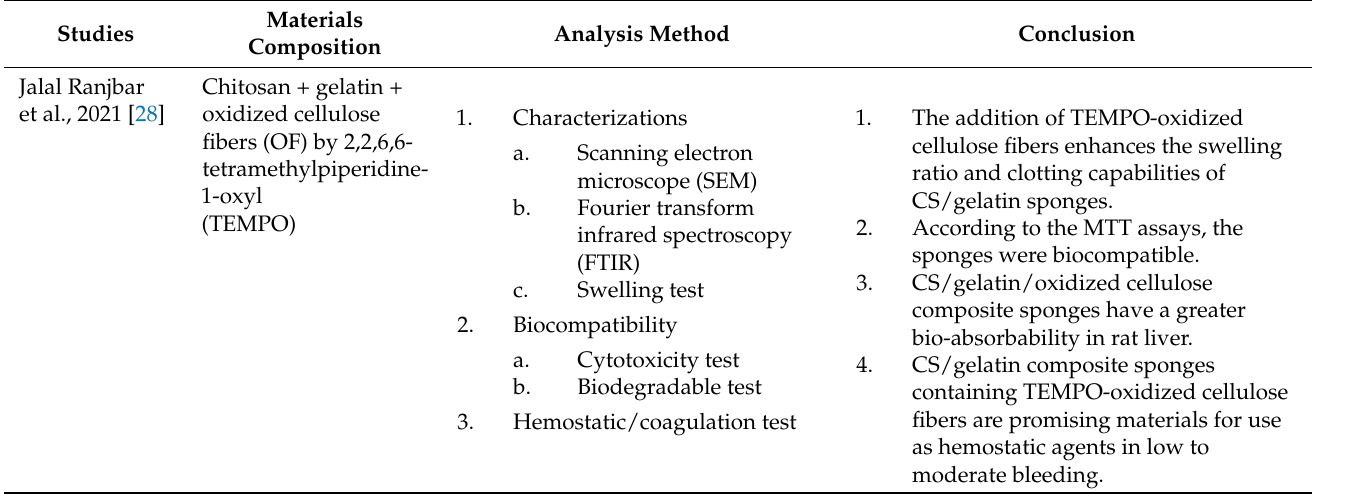
Table 3. Analysis of characterization methods, biocompatibility test and hemostatic test.